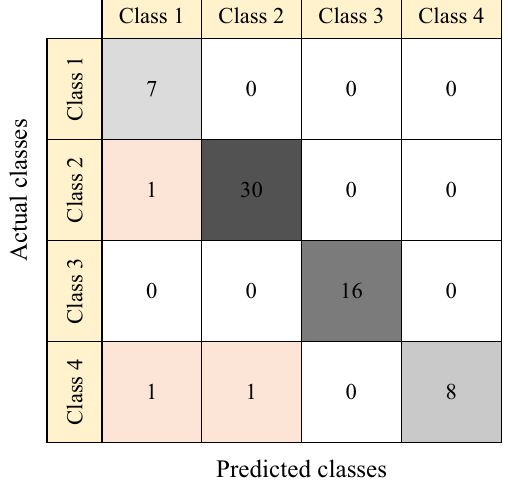
Fig. 16 Confusion matrix of ANN algorithm applied to data